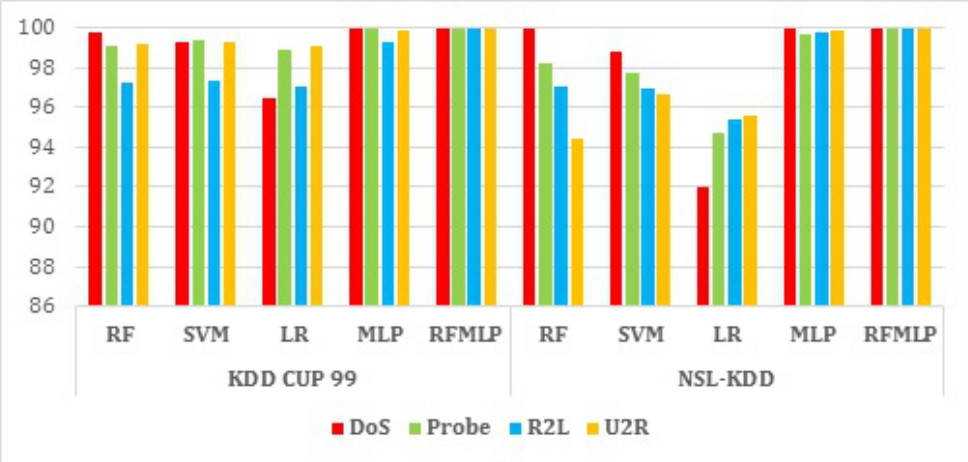
Figure 4. Performance comparison of all models on KDD-CUP 99 and NSL-KDD.